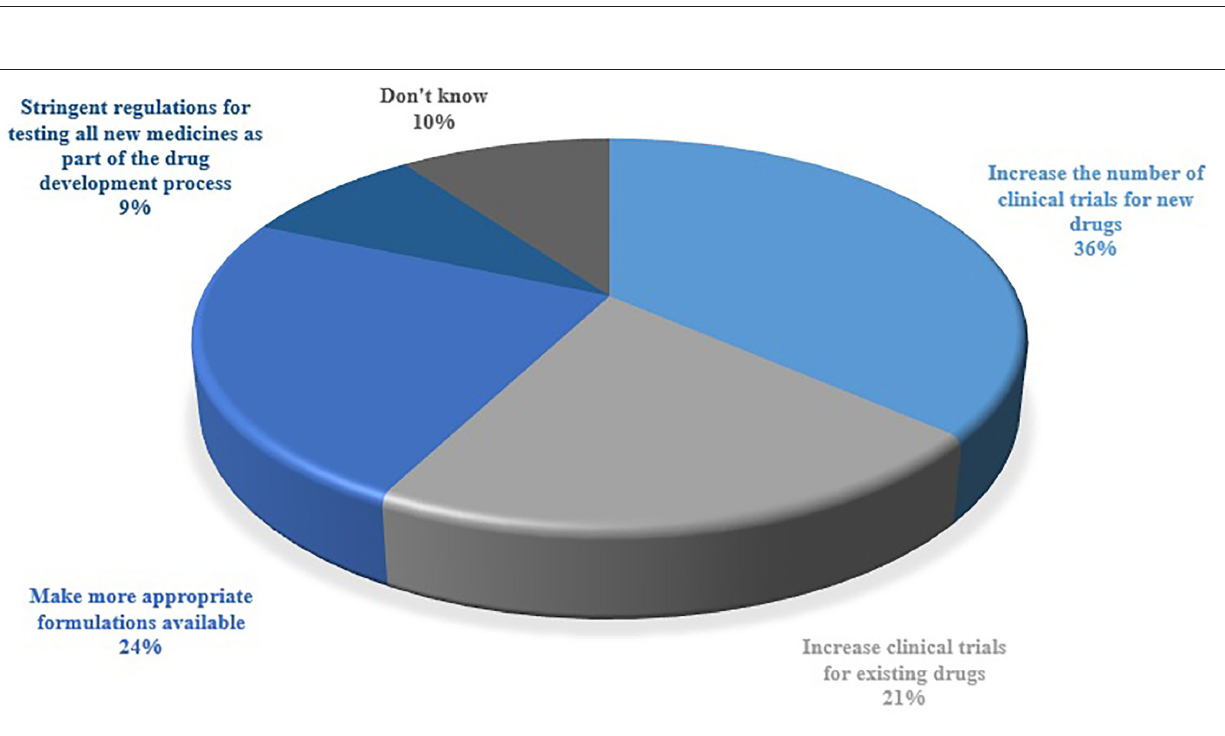
FIGURE 4 | Respondents’ perceived beneficial factors in reducing the OLMU for infertility treatment.